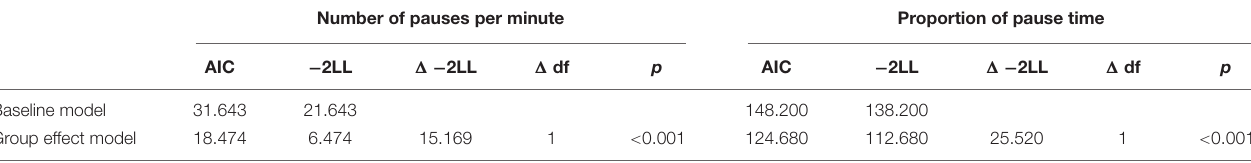
TABLE 4 | Comparison of the baseline and the group effect models for number of pauses per minute and proportion of pause time.